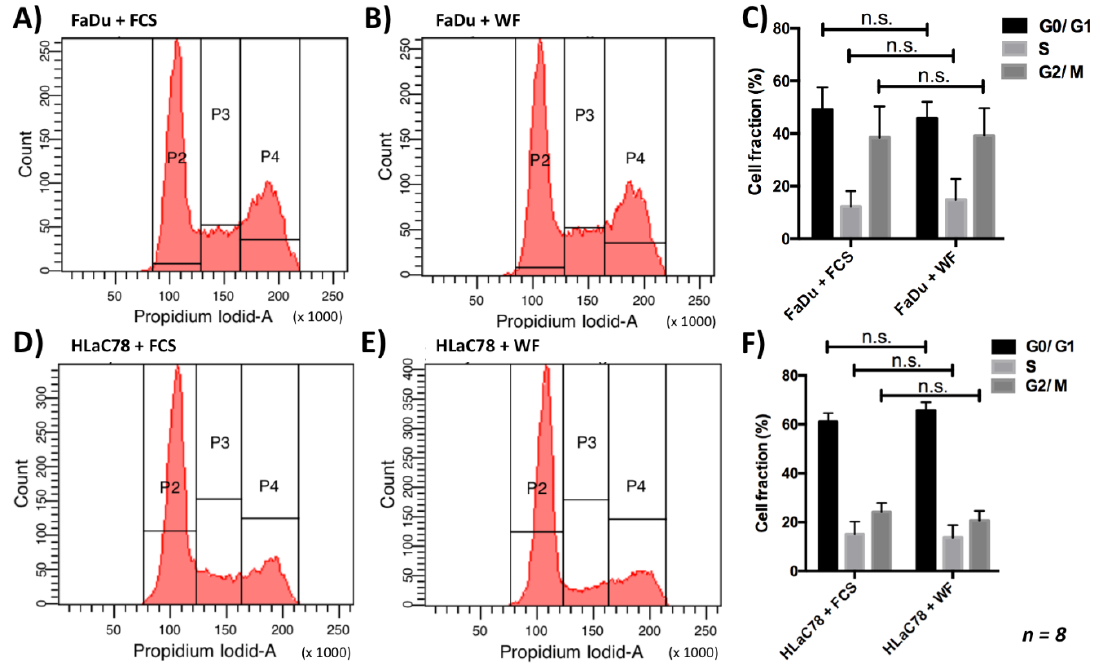
Figure 4. There is no change in the cell cycle distribution by incubation of ( A – C ) FaDu and ( D – F ) HLaC78 cells with 40% WF compared with incubation with FCS. This experiment was repeated with WF of 8 different donors. n.s. marks the not significant results.